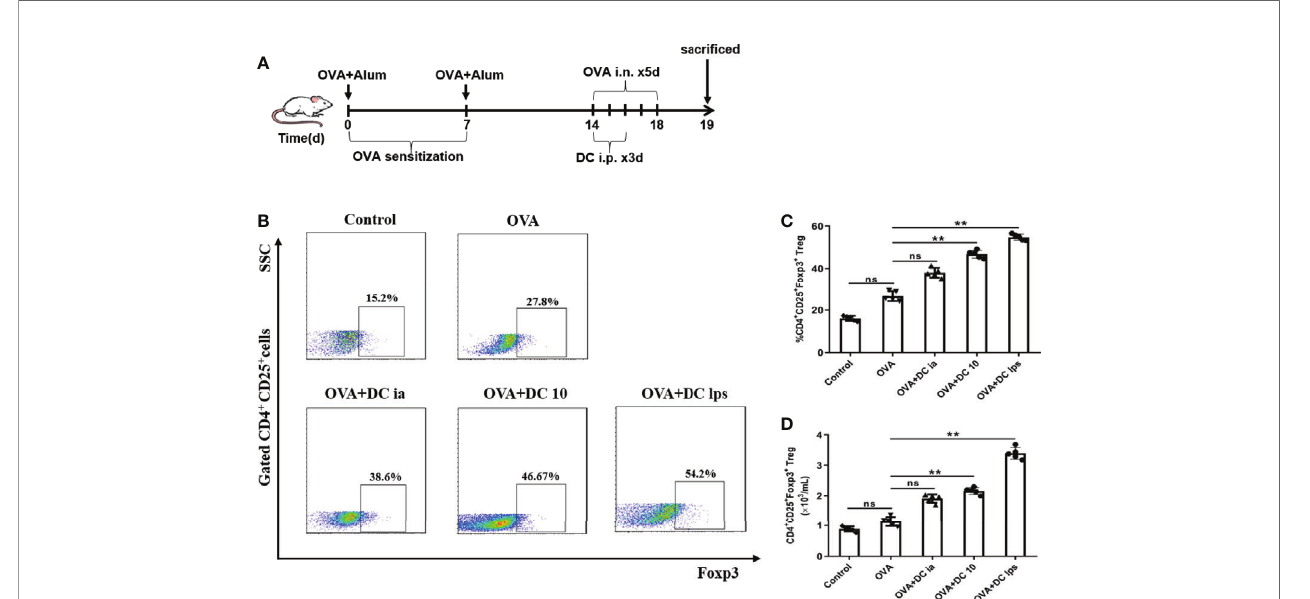
FIGURE 7 | Adoptive transfer of DClps increased the number of pulmonary Tregs in OVA-induced asthmatic mice. (A) Schematic of the OVA-induced asthmatic mouse model. (B) Pulmonary Tregs were characterized as CD4 + CD25 + Foxp3 + cells by FCM. (C) Percentage of pulmonary Tregs determined by FCM. (D) Numbers of pulmonary Tregs determined by FCM. The columns and error bars represent the mean and SEM. (**P < 0.01, ns, no signi fi cant difference, ANOVA with Tukey ’ s post hoc analysis). The same experiment was repeated three times with similar results (n = 5 in each group).